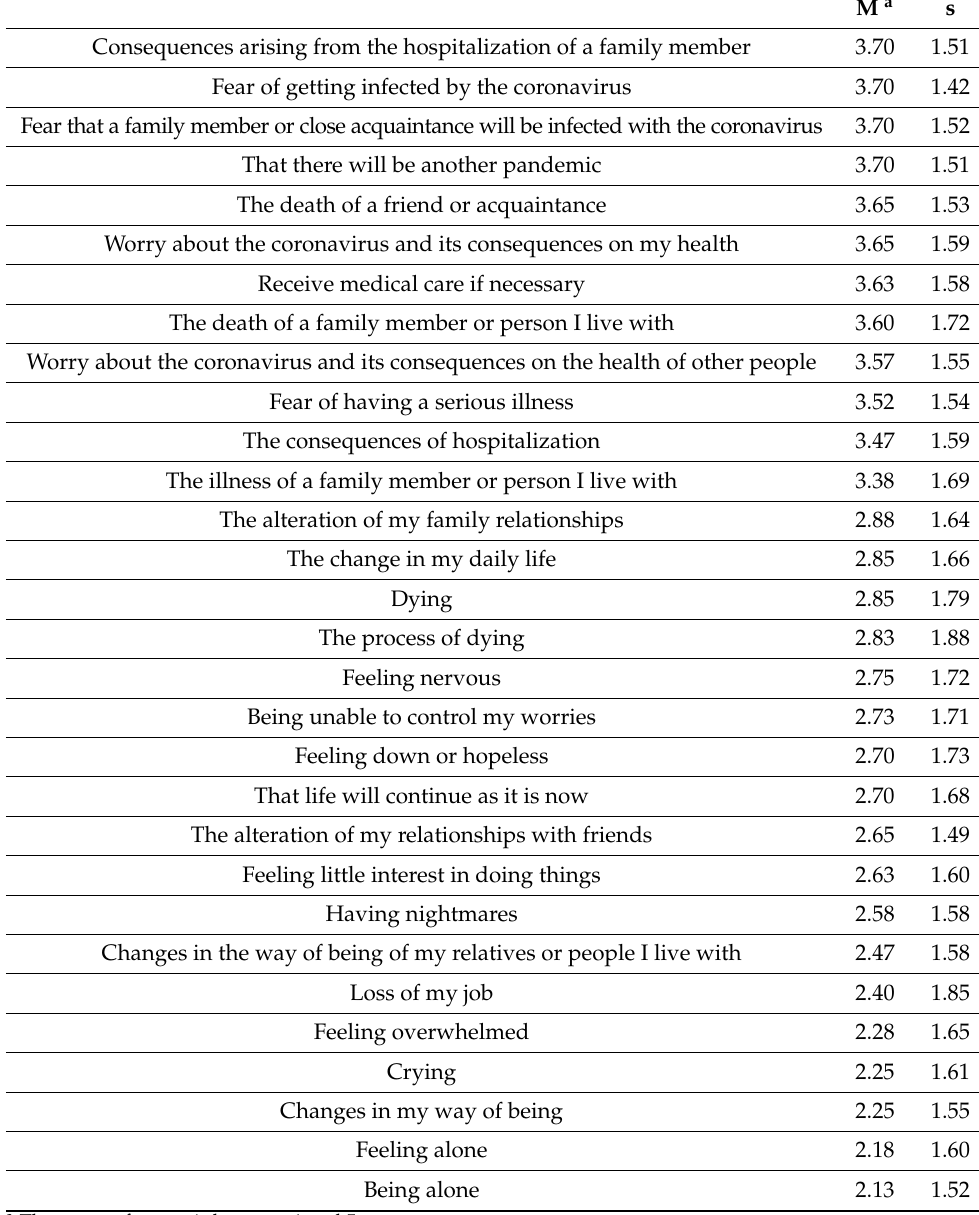
Table 3. Average concern generated for the participants in the study of different aspects associated with the pandemic